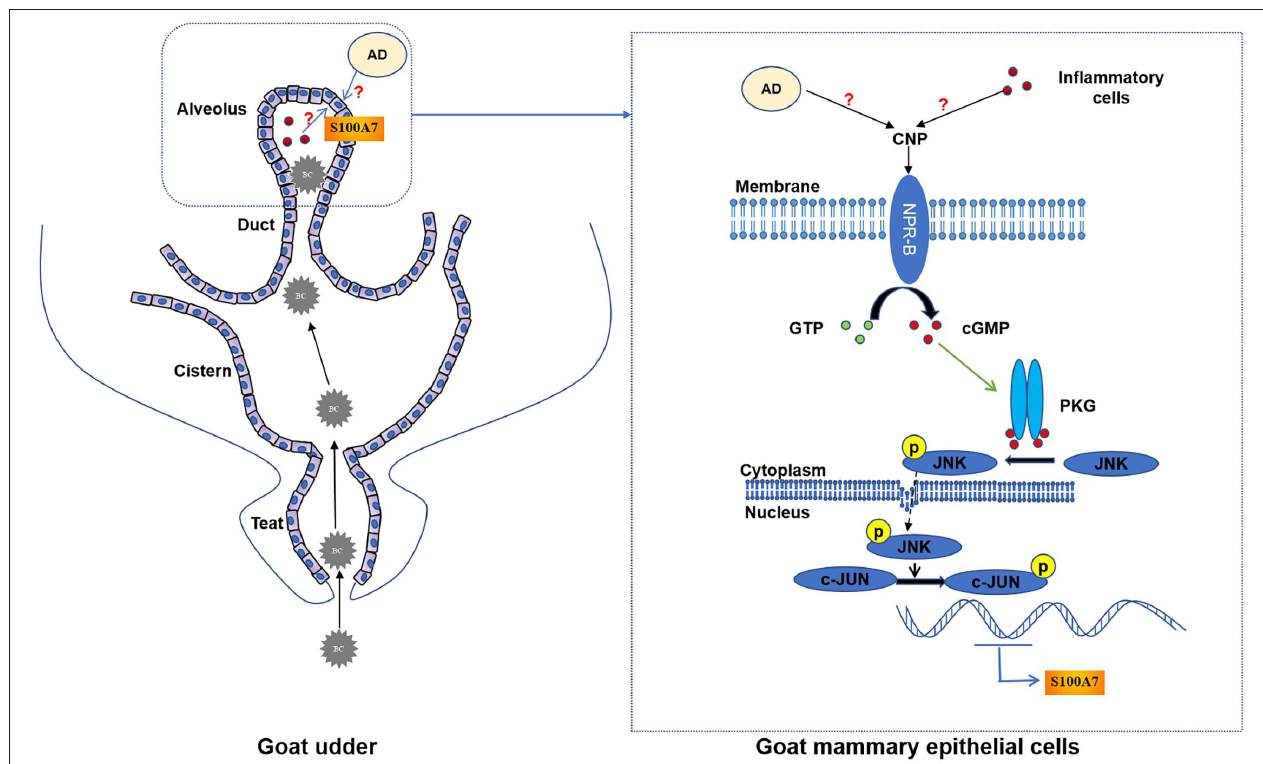
FIGURE 8 | The schematic mechanistic diagram. In goat udder, bacteria (BC) pass through the teat canal and then enter the cistern and alveolus, resulting in intramammary infection. During intramammary infection, adipose tissue (AD) or inflammatory cells may secrete CNP. CNP binds to NPR-B and activates the guanylate cyclase activity of NPR-B. Activated NPR-B induces the production of cyclic guanosine monophosphate (cGMP), thereby activating PKG. PKG phosphorylates JNK and phosphorylated JNK phosphorylates the downstream target c-Jun. Finally, phosphorylated c-Jun as a transcription factor induced the expression of S100A7 in